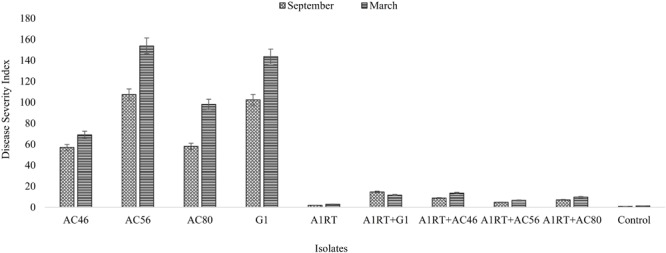
Graphical representation of disease severity index calculated after harvesting. Error bars represent standard error. The results shown in triplicates (p < 0.05).